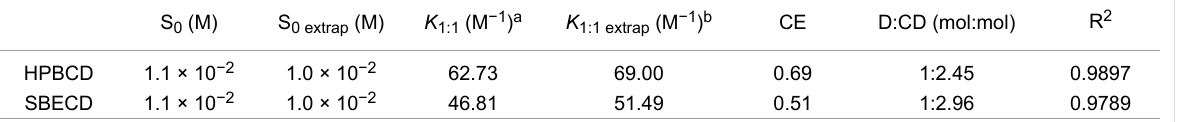
Table 1: Values for K 1:1 , CE and the D:CD ratio obtained from the fluconazole–cyclodextrin complex in water at 25 °C.